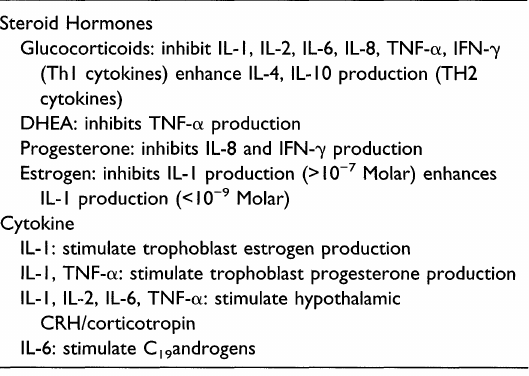
TABLE I. Steroid Hormone--Cytokine Interactions Steroid Hormones Glucocorticoids: inhibit IL-I, IL-2, IL-6, IL-8, TNF-c,